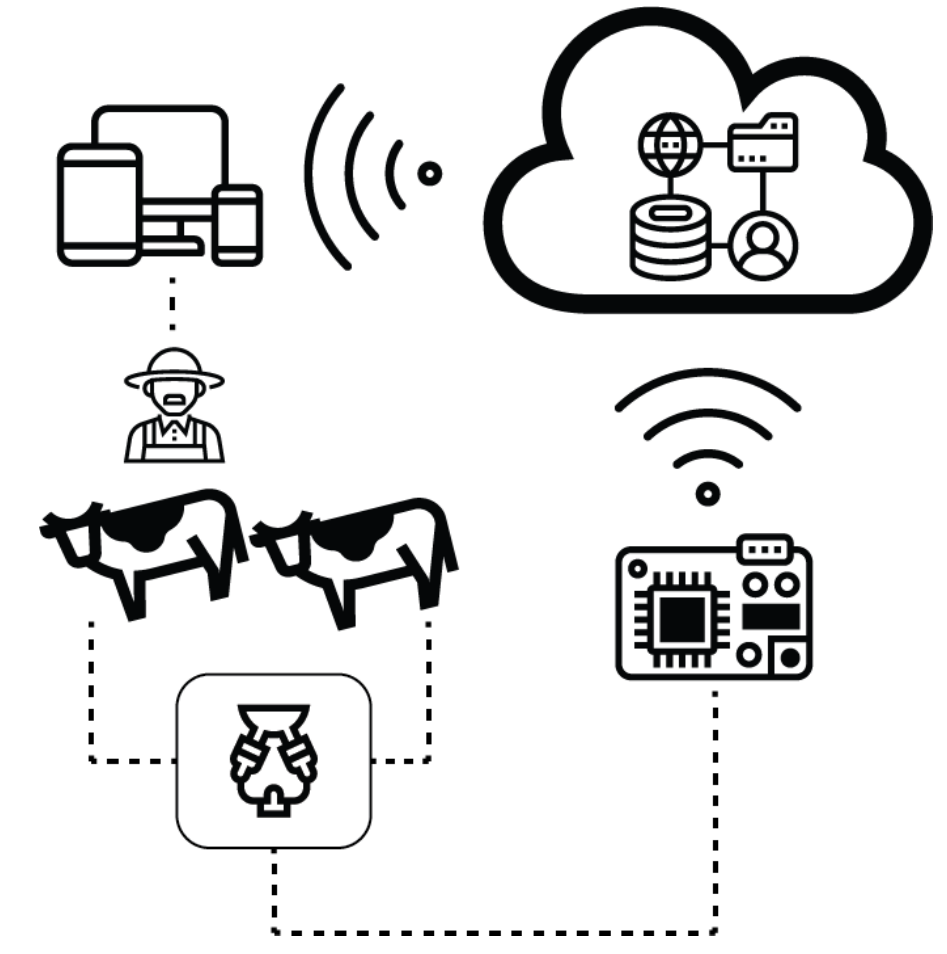
Figure 4. Smart farming applied to milking parlors.